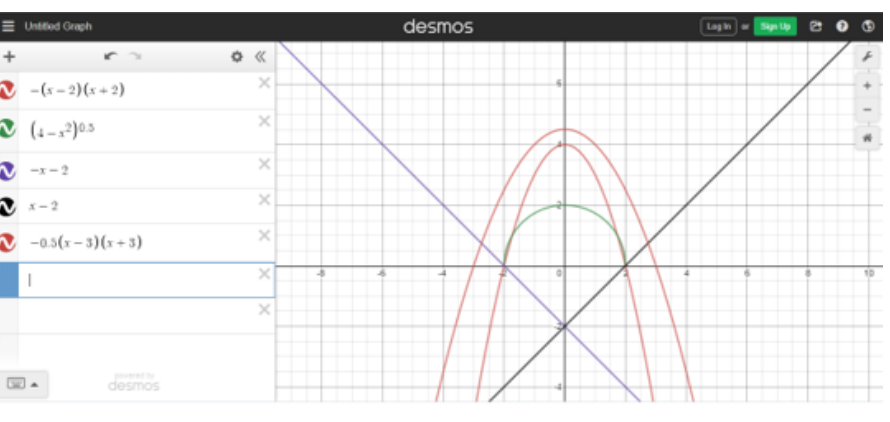
Figure 1. Pedagogical Challenge—functions defining the boundaries of the future